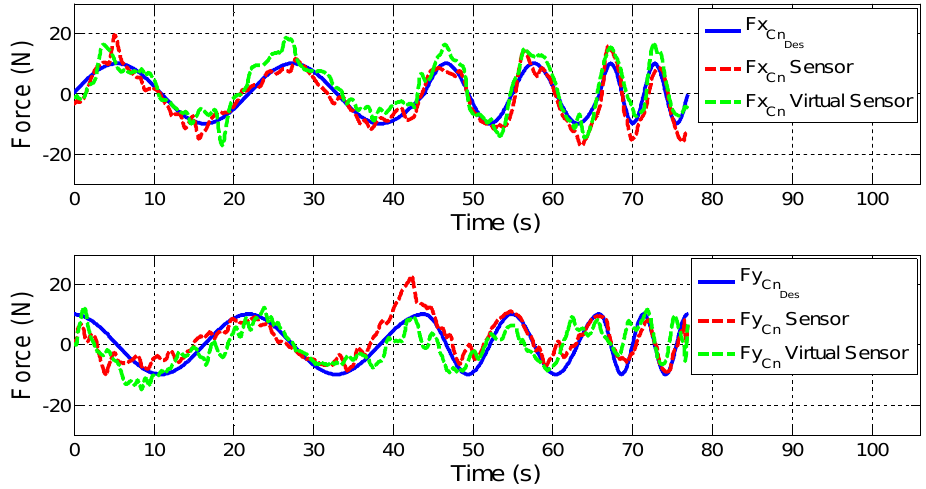
Figure 12. Validation of the Force Virtual Sensor in the WRIST operating mode with variable force